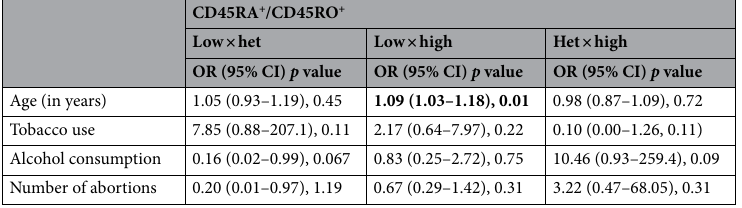
Table 4. Logistic regression analysis in CD45RA + /CD45RO + ‘immunoscore’ data. The bold values mean statistical differences between the groups.